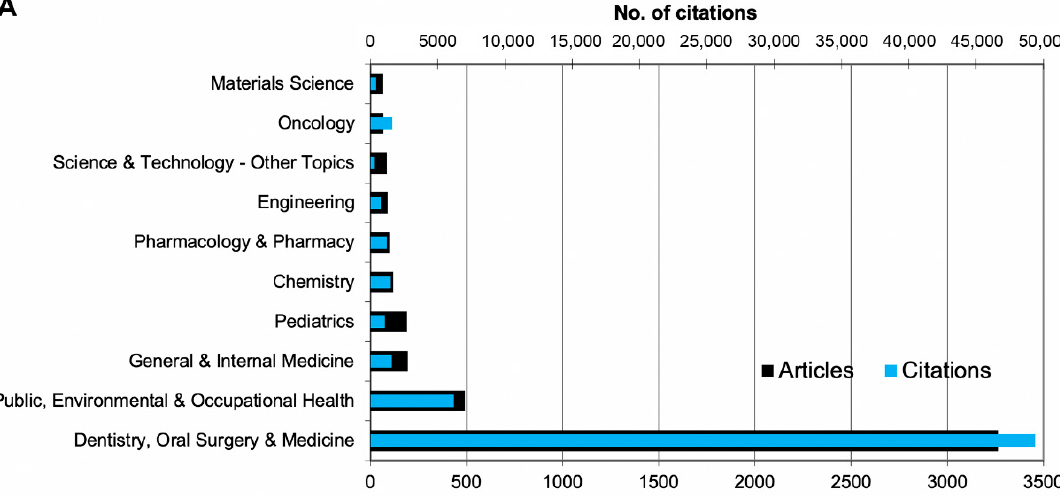
Figure 5. Subject areas of Web of Science categories. ( A ) Ten most frequently assigned areas with number of articles and citations. ( B ) Relative distribution of the most frequently assigned subject areas in 5-year intervals from 1966–2015. 4. Discussion The aim of the present study was to analyze and interpret the global publication out- put on oral health according to various parameters. The results showed a very differenti- ated pattern. A total of 4812 articles on oral hygiene were published in WoS, of which 4350 articles could be used for the geographic analyses. The publication numbers as well as the number of citations were shown to increase significantly over time. The article count reached a peak in 1964 (Figure 1) when the term “oral hygiene” was coined in the most frequently cited article of this study, “Simplified Oral Hygiene Index”, by Green & Vermillion [18].